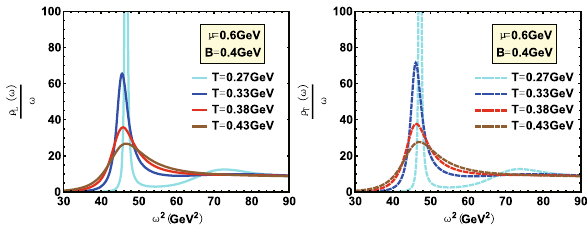
Fig. 11 The spectral function of the ϒ( 1 S ) state for different temper- ature T . The left picture is for magnetic field parallel to polarization and the right one is for magnetic field perpendicular to polarization